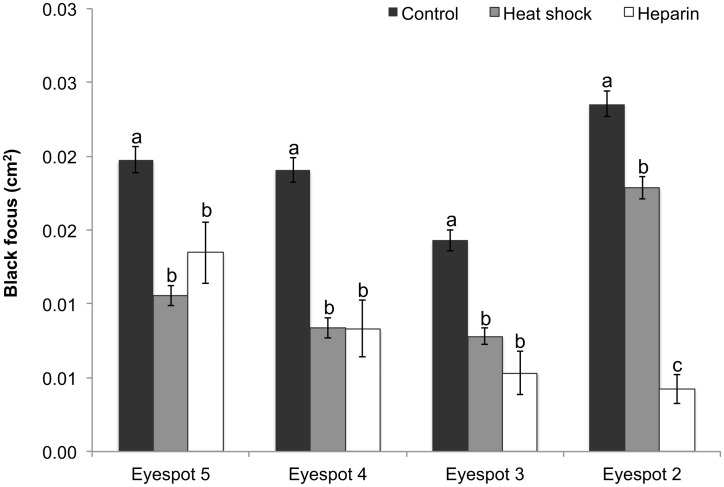
Area of the black focus across all four eyespots in the different treatments.Data represent the area in cm2 with error bars representing 1 SE from the mean. The 2-way ANCOVA was performed on square-root transformed data. Results shown in Table 1. Different letters above the bars indicate significant differences within each individual eyespot.